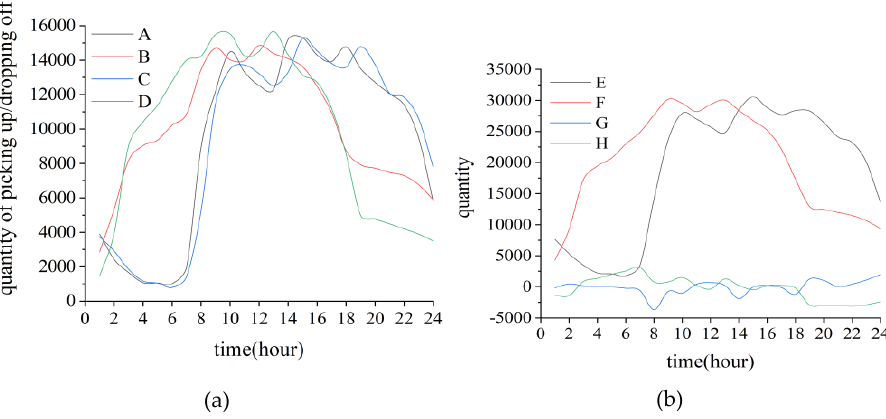
Figure 4. Characteristics of resident trips in the study area. ( a ) quantity of pickups / drop-o ff s on workdays / weekends. A represents the quantity of pickups on workdays; B represents the number of pickups on weekends; C represents the quantity of drop-o ff s on workdays; D represents the quantity of drop-o ff s on weekends; ( b ) quantity of tra ffi c volume / inflow on workdays / weekends. E represents the tra ffi c volume on workdays; F represents the tra ffi c volume on weekends; G represents the inflow on workdays; H represents the inflow on